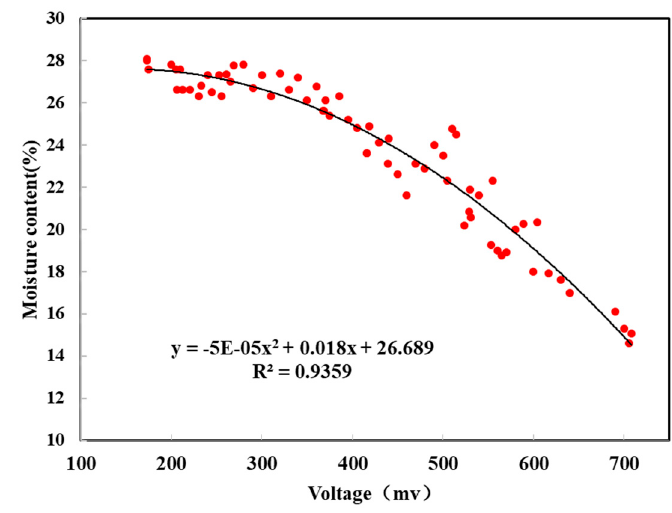
Figure 8. The relationship between sensor voltage and obtained rice moisture.